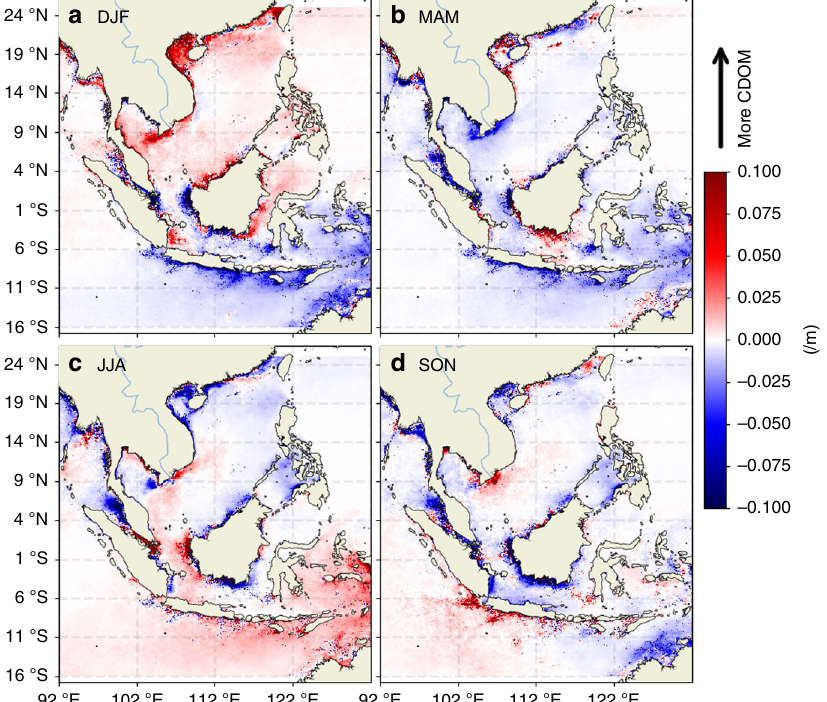
Fig. 6 Composite seasonal maps of Colored Dissolved Organic Matter anomalies. a – d correspond to the maps for the DJF, MAM, JJA, and SON